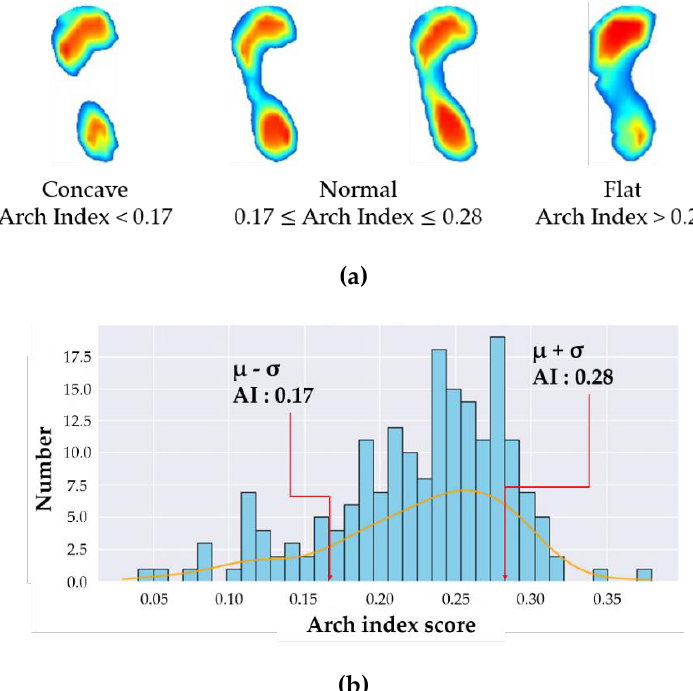
Figure 3. Labeled results and histogram of arch index data. ( a ) Arch index method and labeled image data, ( b ) Distribution of the data.